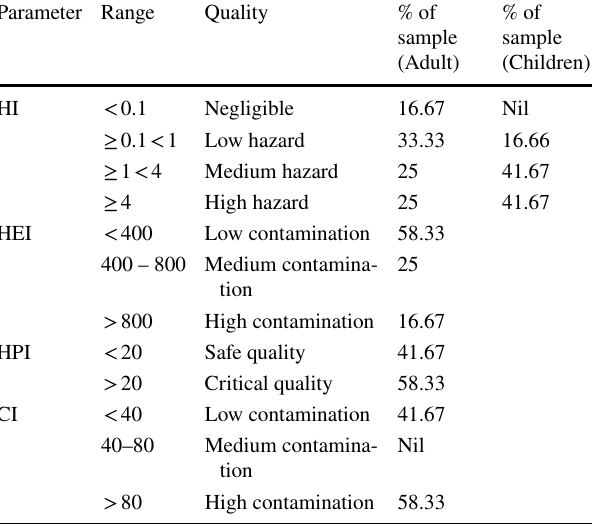
Table 9 Classification of water based on HI, HPI, HEI, and CI Parameter